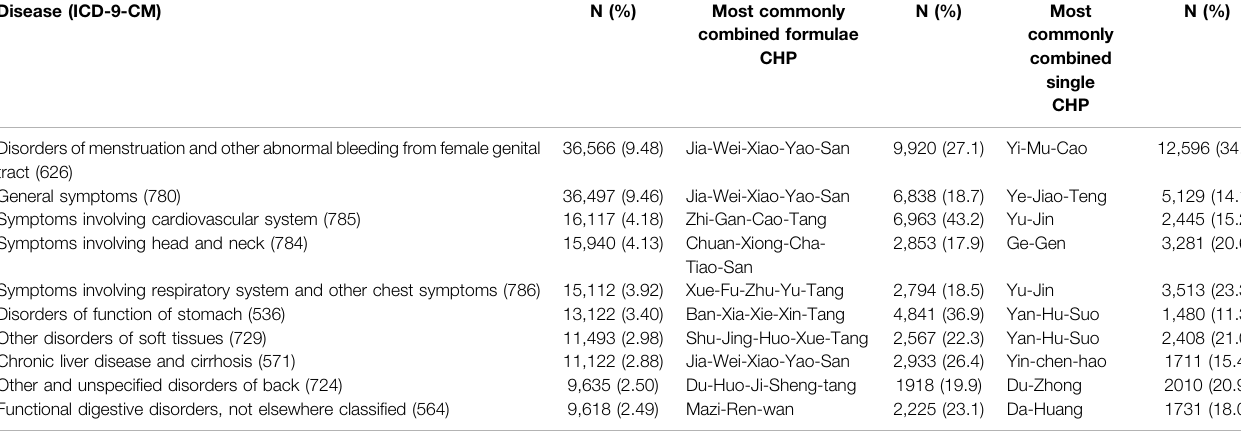
TABLE 2 | Top 10 diseases (primary code) treated with radix Salvia miltiorrhiza from 2000 to 2011 in Taiwan. Disease (ICD-9-CM) N (%) Most commonly